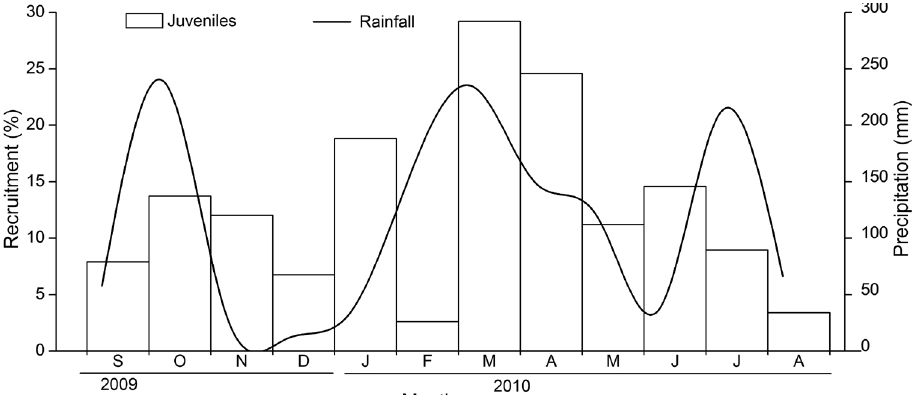
Rio Salsa, Canavieiras, Bahia, Brazil.